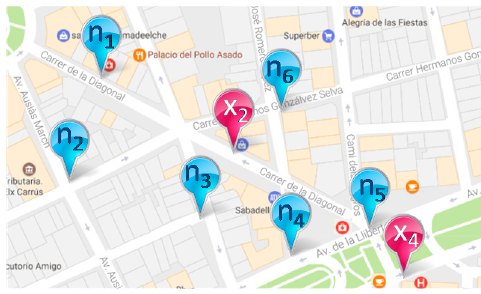
Figure 7. Neighbouring sensors in blue of the sensor located in X 2 .